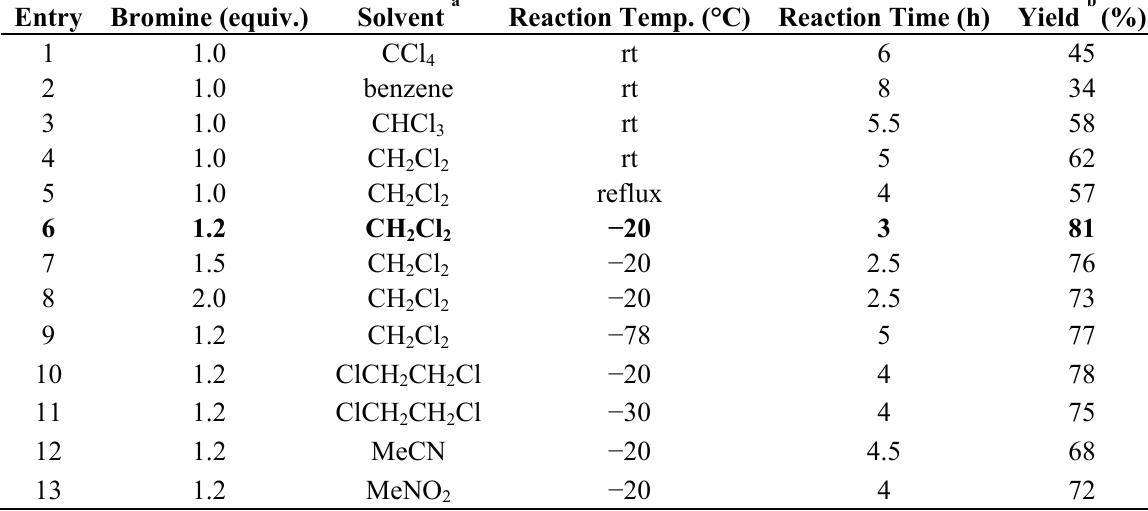
Table 1. Screening of the reaction conditions for the electrophilic cyclization reaction of the dimethyl 3-methyl-1-(tetrahydro-2 H -pyran-2-yloxymethyl)-penta-1,2-dienephosphonate 1a with